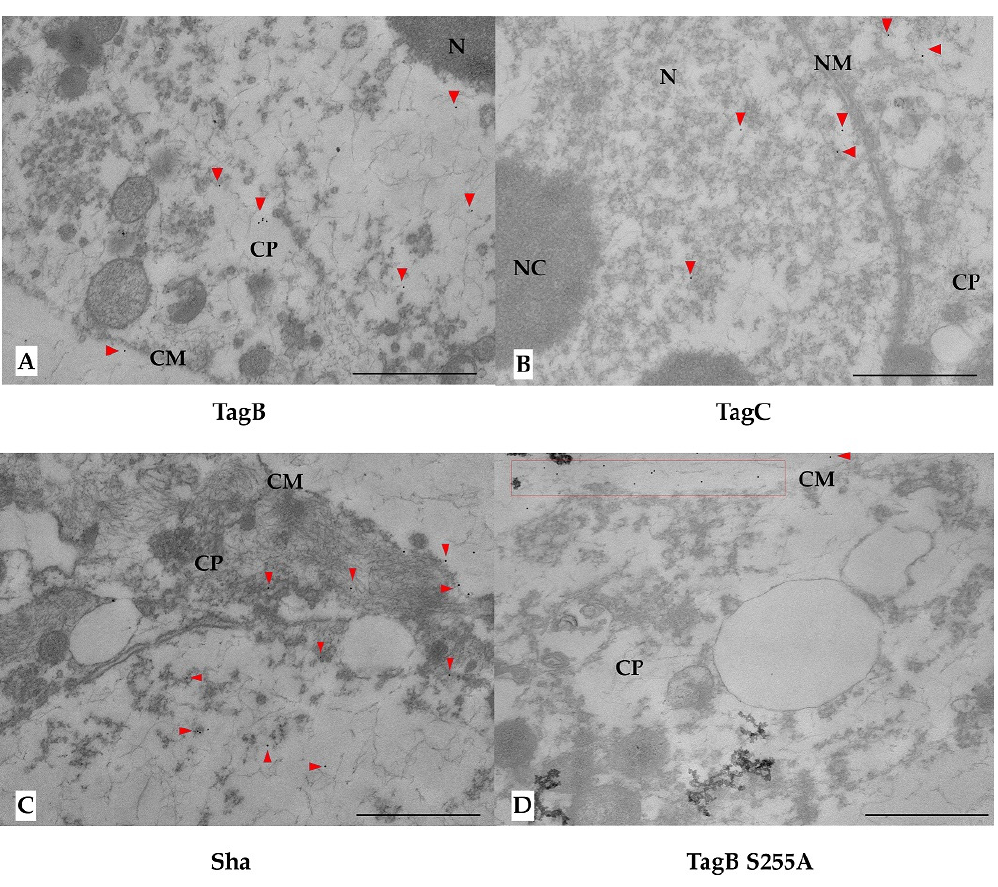
Figure 6. Transmission electron micrographs of 5637 bladder cells showing internalized SPATEs, immunolabelled with 10-nm-diameter gold particles after 5 h of incubation. Gold particles are highlighted with red triangles. ( A ) TagB is principally located in the cytoplasm (CP). ( B ) For Tag C, gold particles were associated with the nucleus (N) and cytoplasm (CP). ( C ) Sha was located mainly in the cytoplasm (CP). ( D ) For the serine mutant variants of TagB, TagC, and Sha, gold particles were only localized on the extracellular surface of cells (red box). Only the TagB S255A mutant protein localization is shown. Cell membrane (CM), Cytoplasm (CP), Nuclear Membrane (NM), Nucleus (N), Nucleolus (NC) Bars, 1 µm.